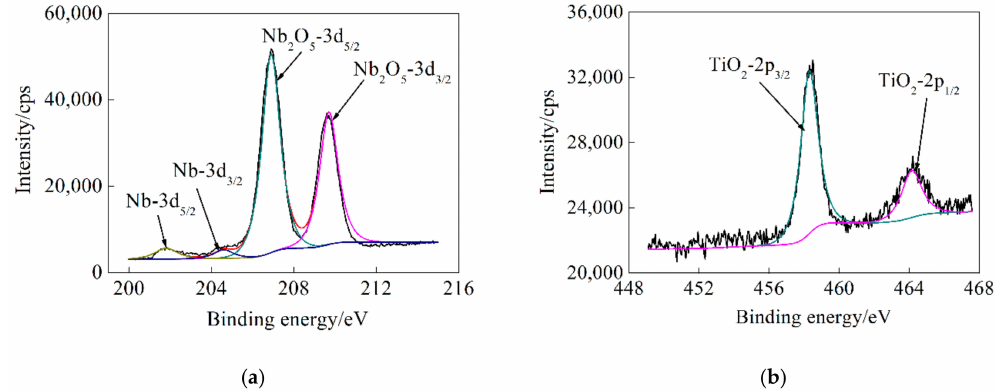
Figure 4. X-ray photoelectron spectroscopy (XPS) spectra of ( a ) Nb 3d and ( b ) Ti 2p (original-black lines, fitted-red lines) measured on TiNb / 316L SS.